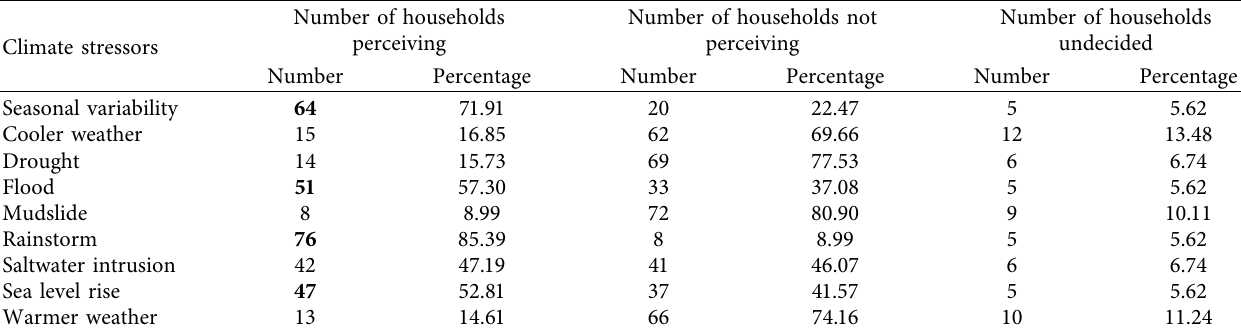
Table 5: Number of households reporting climate-related threats.